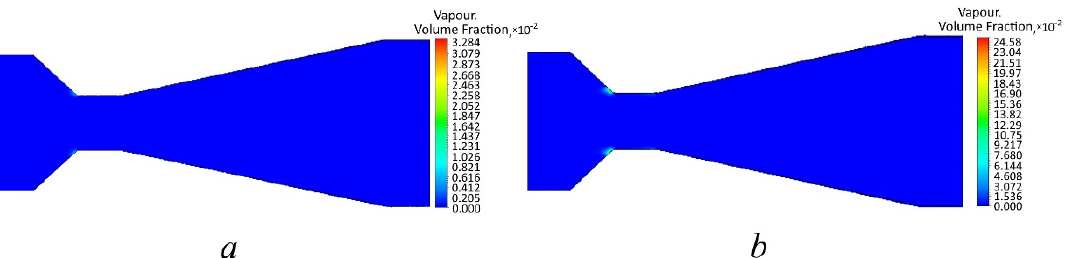
Figure 7. Absolute pressure p abs and flow velocity υ along inverted Venturi tube (from our CFD results).